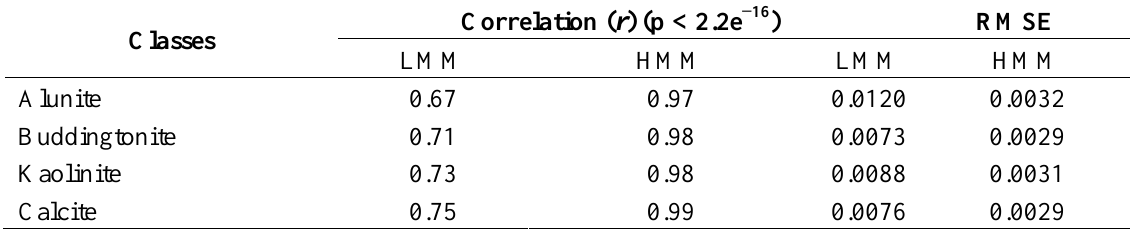
Table 2. Correlation and RMSE between actual and predicted proportions for simulated